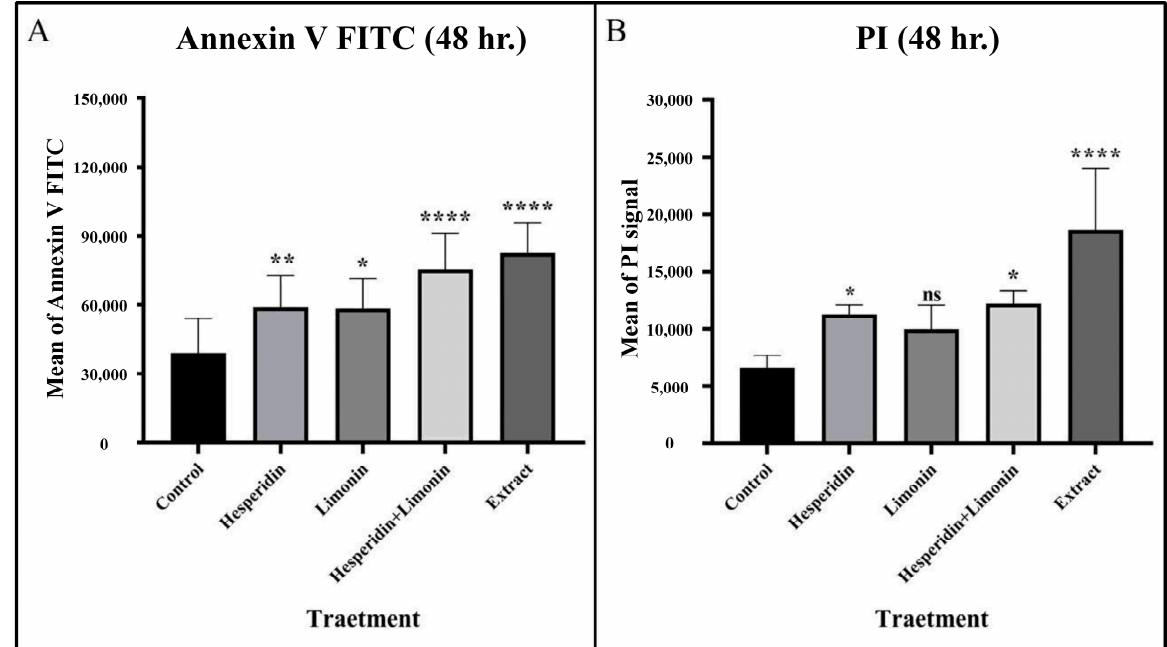
Figure 9. The mean and SD of Annexin V FITC ( A ) and PI ( B ) that stained in PLC/PRF/5 human hepatocellular carcinoma cells from flow cytometry analysis at 48 hr in each treatment. The statistical differences were analyzed by using one-way ANOVA followed by the Bonferroni comparisons test. The symbol ns, *, **, and **** mean p > 0.05, < 0.05, <0.01, and <0.0001, respectively.